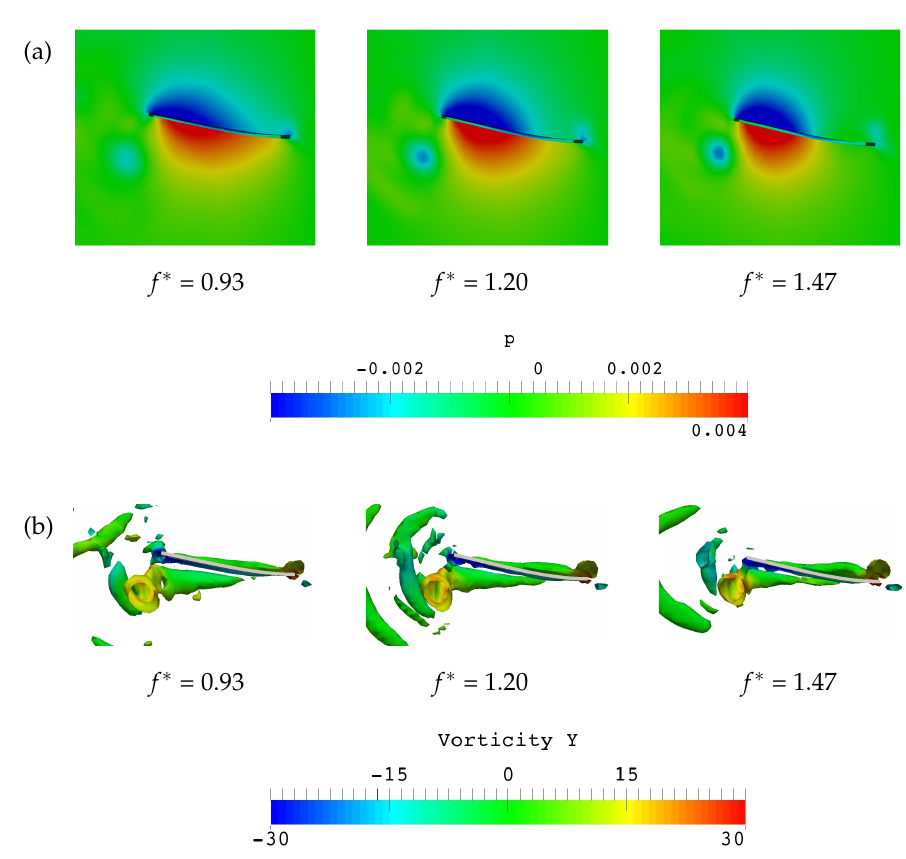
Figure 11. ( a ) Pressure distributions on the spanwise symmetry plane of the plate and ( b ) three- dimensional vortex structures at the phase instant when a peak value of thrust appears in each case.